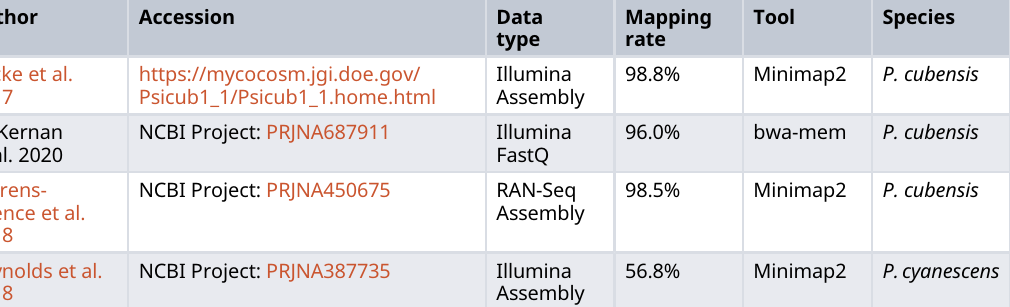
Table2.Three Psilocybecubensis datasetsinNCBIandJGIwerealignedtotheP.envyHiFireference. Adifferent Psilocybe species ( Psilocybe cyanescens ) genome was also mapped with much lower mapping